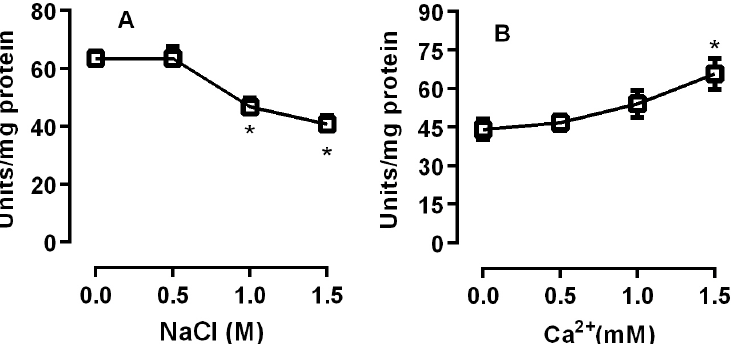
Figure 3. Effects of NaCl and calcium concentrations on the lipase activities of the posterior midgut homogenate (crude extract) of R. palmarum larvae. The incubations were performed with different NaCl concentrations ( A ) and with different calcium concentrations ( B ). The error bars represent the SD for the three determinations (* p < 0.05).